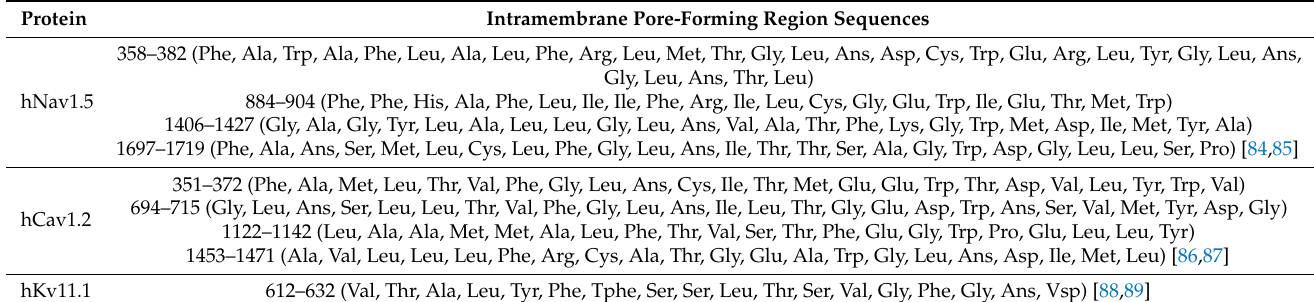
Table 4. The composition of the binding pocket of the analyzed channel models: hNav1.5, hCav1.2 and hKv11.1. Protein Intramembrane Pore-Forming Region